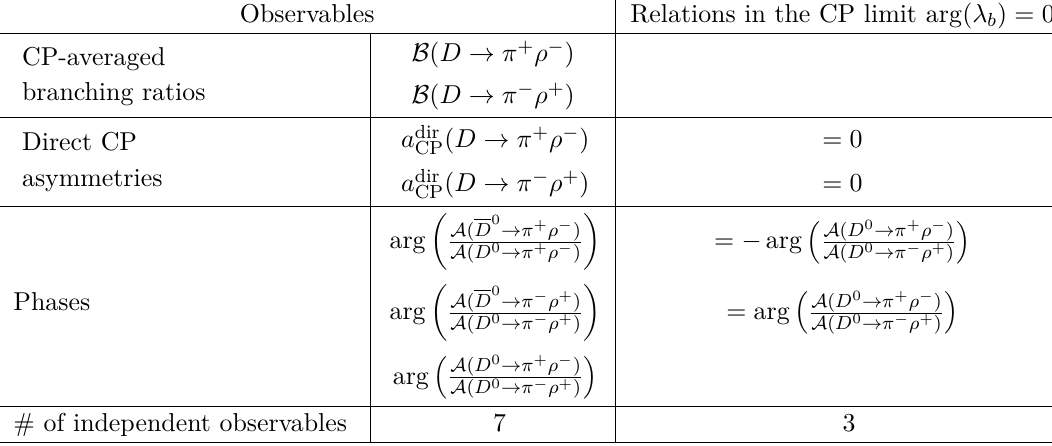
Table 1 . Available observables for D → π ± ρ ∓ and relations between them in the CP limit. The CP-averaged branching ratios are defined in eqs. (3.7) and